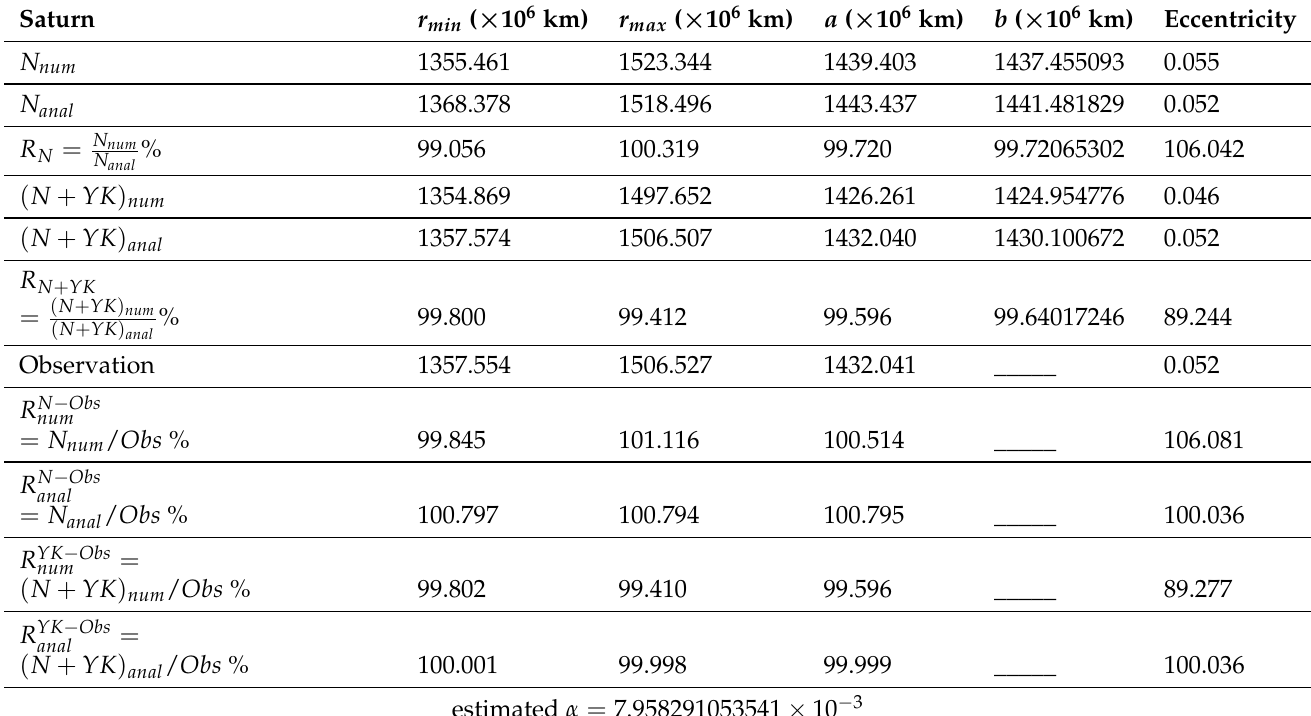
Table A12. The values of the calculated and observational astronomical parameters, for estimated α , of the planet Saturn, whose number of moons is 0.